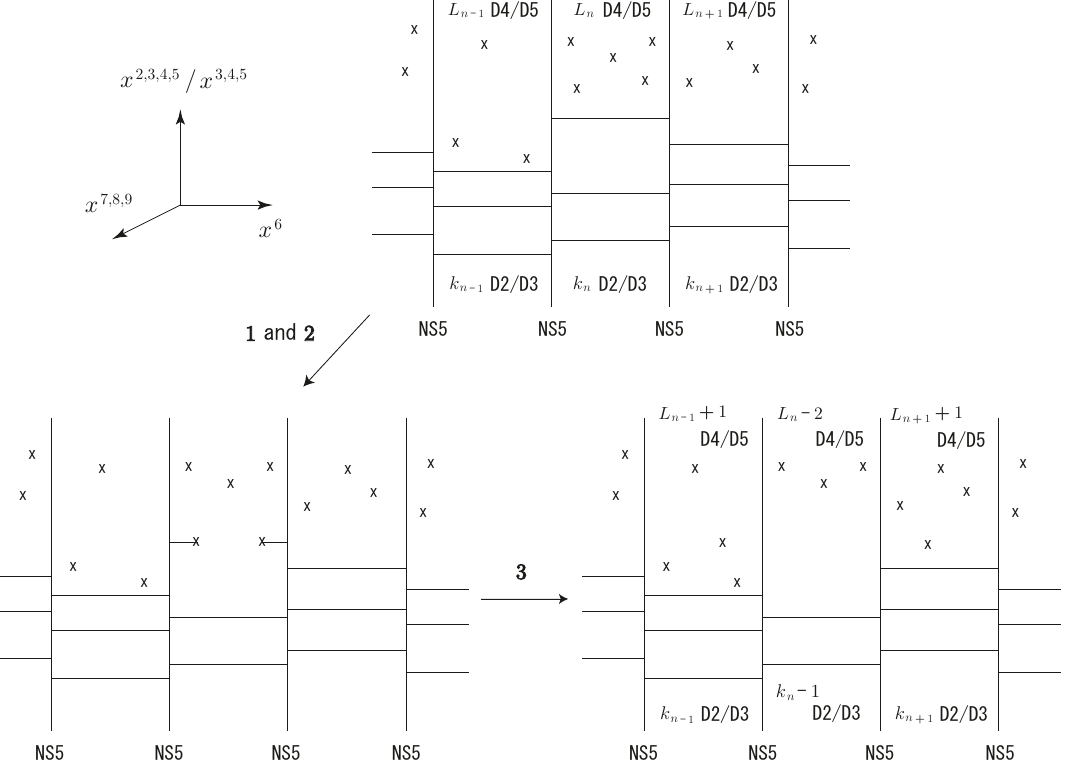
Figure 4 . The Higgsing procedure including Hanany-Witten moves for type-IIA/IIB brane con- figuration [16], where the vertical (resp. horizontal) lines represent NS5 (resp. D2/D3) branes, and each x represents a D4/D5 brane. The corresponding quiver description is in figure